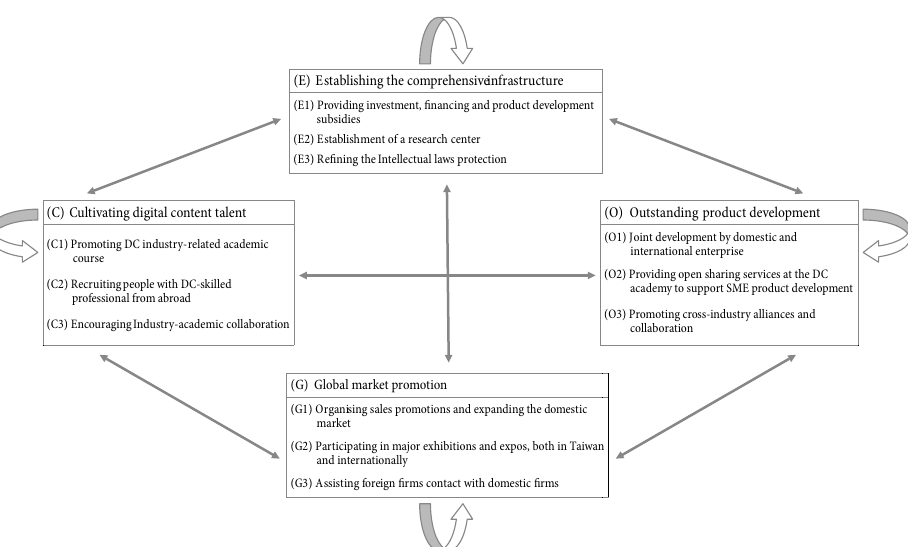
Fig. 1. Dimension interrelation structure for DC development